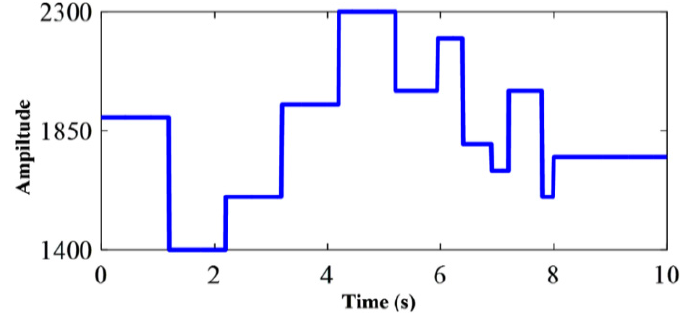
Figure 3. Capacitor bank voltage variations super capacitor voltage (V S ) .